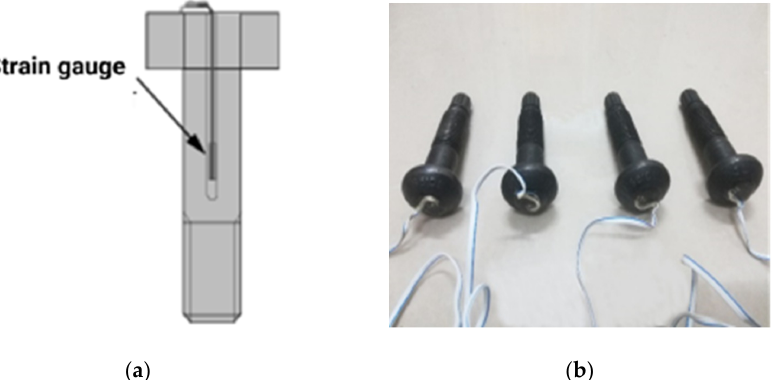
Figure 3. Installation of strain gauge. ( a ) Scheme for strain gauge; ( b ) High-strength bolts with strain